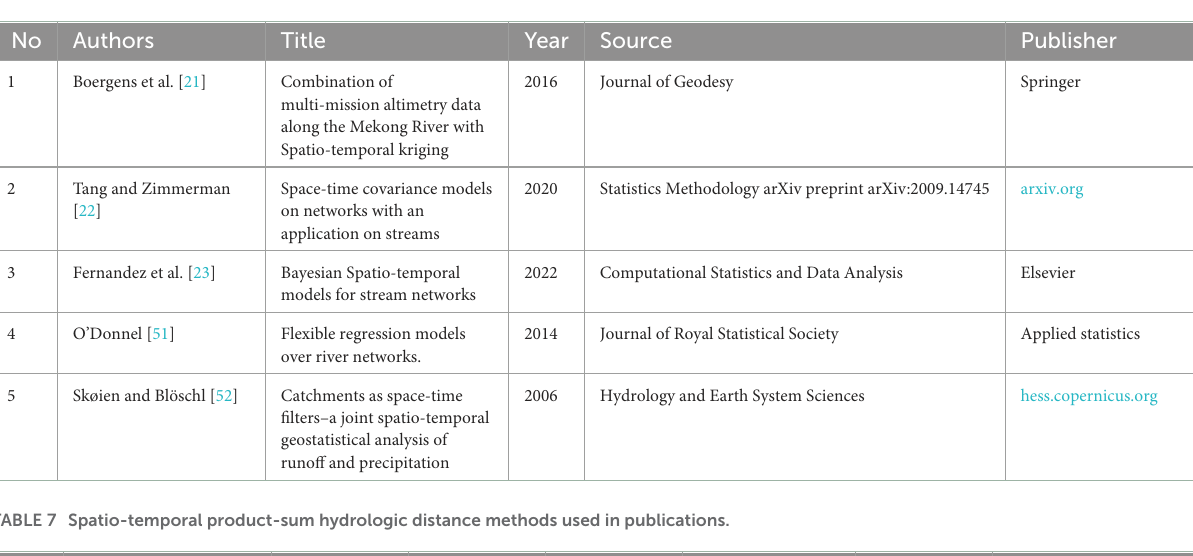
TABLE 6 Spatio-temporal product-sum hydrologic distance publication.